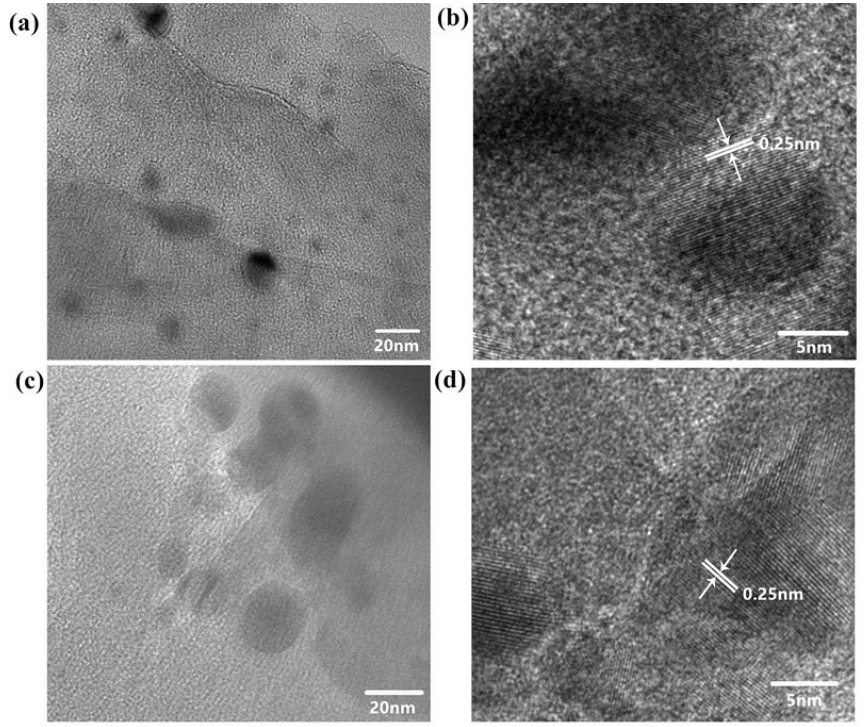
Figure 9. TEM analysis of CS/PVA/MMT@Pd film: ( a ) and ( b ) CS/PVA@Pd film (no reaction); ( c ) and ( d ) CS/PVA/MMT @Pd (after six reactions).